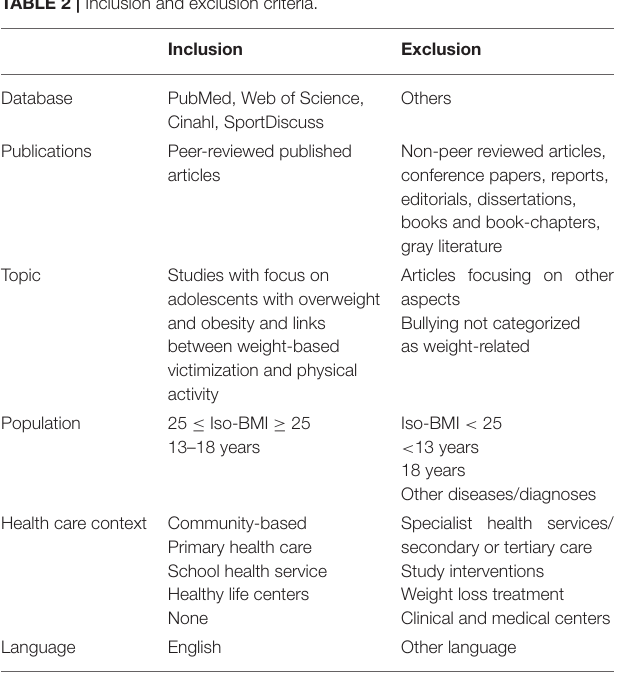
TABLE 2 | Inclusion and exclusion